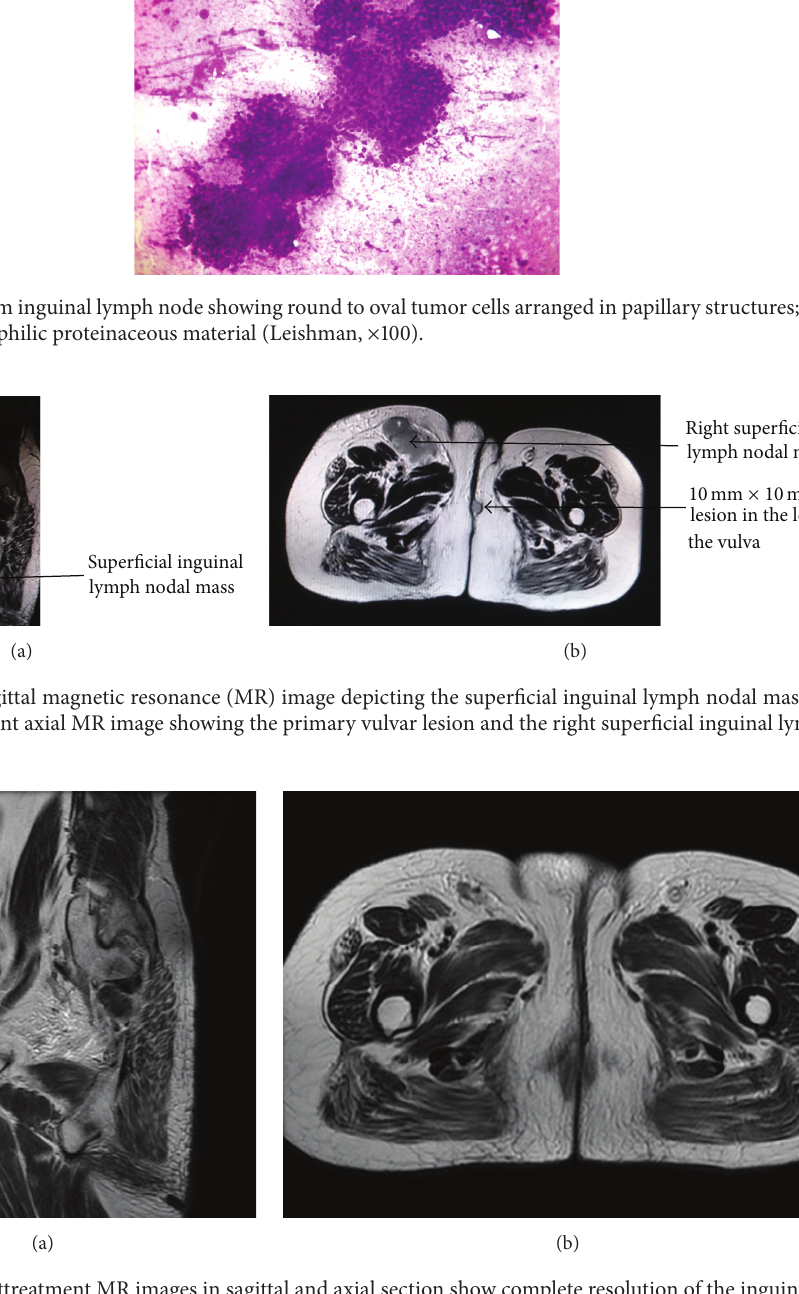
Figure 4: ((a) and (b)) Posttreatment MR images in sagittal and axial section show complete resolution of the inguinal lymph